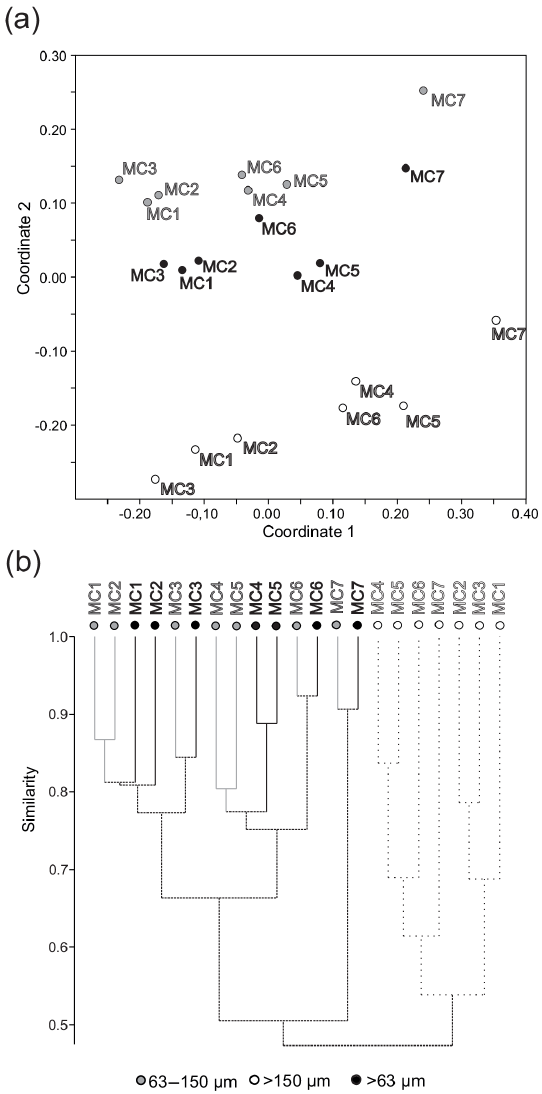
Figure 9. (a) Non-metric multidimensional scaling analysis and (b) cluster analysis (Bray–Curtis similarity measure) considering the densities (ind. 50cm − 2 ) of the major foraminiferal species (relative abundance > 5% in at least one station in one size fraction) for the 63–150µm fraction, the > 150µm fraction and the > 63µm total